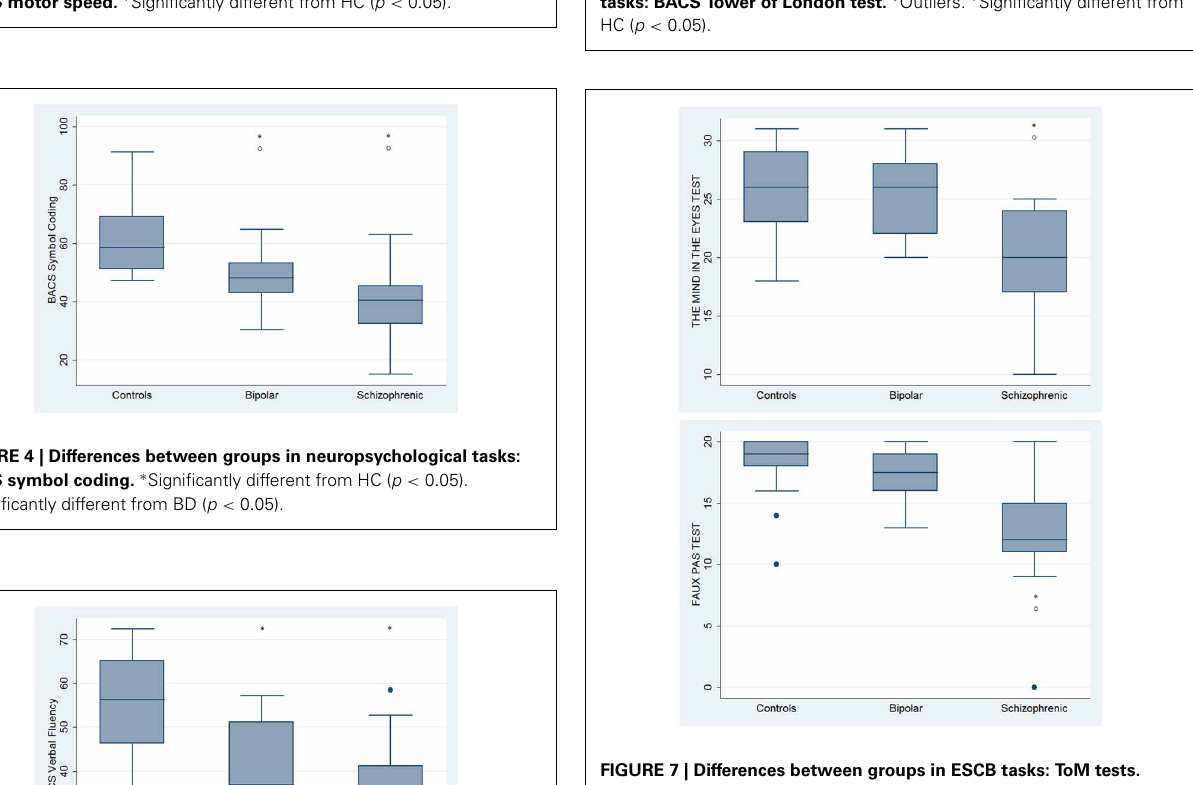
FIGURE 7 | Differences between groups in ESCB tasks: ToM tests. • Outliers. ∗ Significantly different from HC ( p < 0 . 05). ◦ Significantly different from BD ( p < 0 .